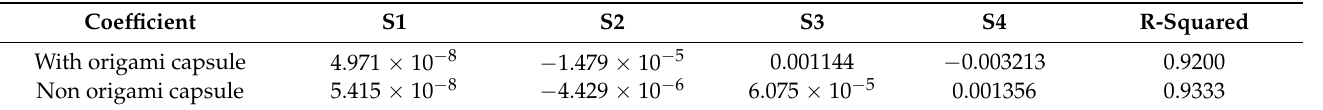
Table 8. Values of the linear equation coefficients and parametric coefficients for origami and non- origami capsules.